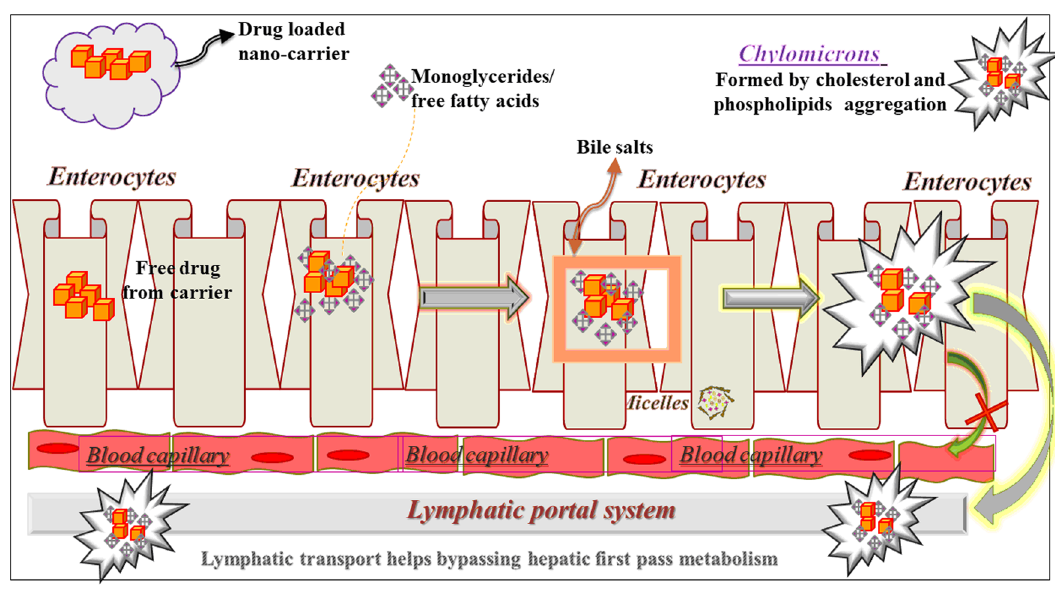
Figure 4: Schematic representation of the absorption of drugs from NLCs in the lymphatic portal system. Drugs incorporated in the NLCs bypass the fi rst - pass metabolism in the liver resulting in increased e ff ectiveness [ 97 ]